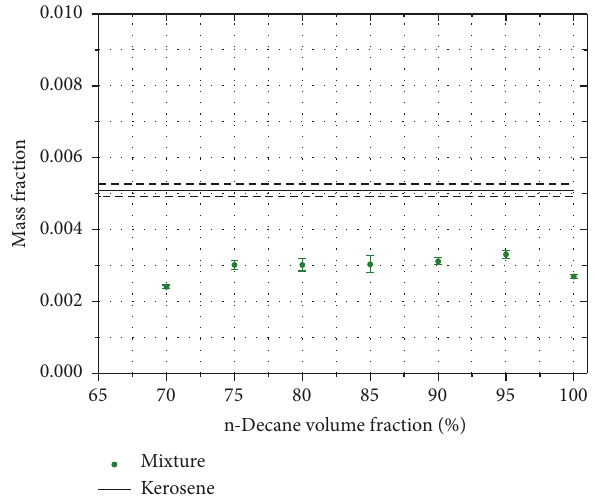
Figure 4: Comparison of mass fraction of CO for the surrogate and the kerosene